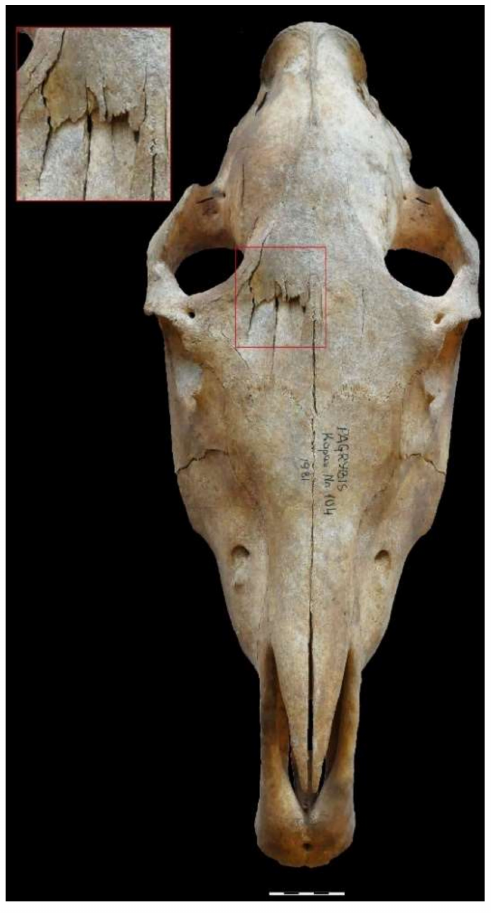
Figure 6. Pagrybis 104 horse male, 3.5–4 years old, with a fractured frontal bone. Individual had upper wolf teeth (P 1 ), and its lower P 2 teeth had traces of bit